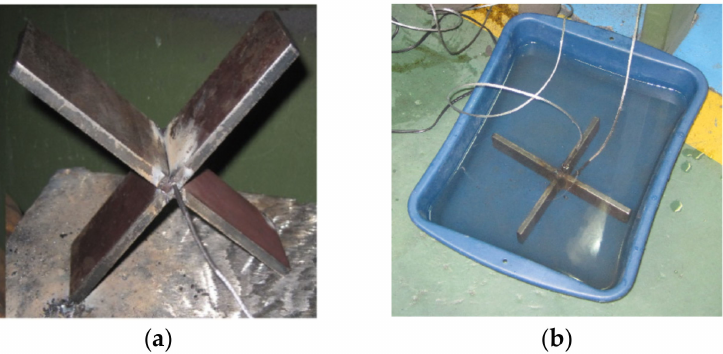
Figure 1. Connection of the thermocouples. ( a ) Welded specimen; ( b ) Connected